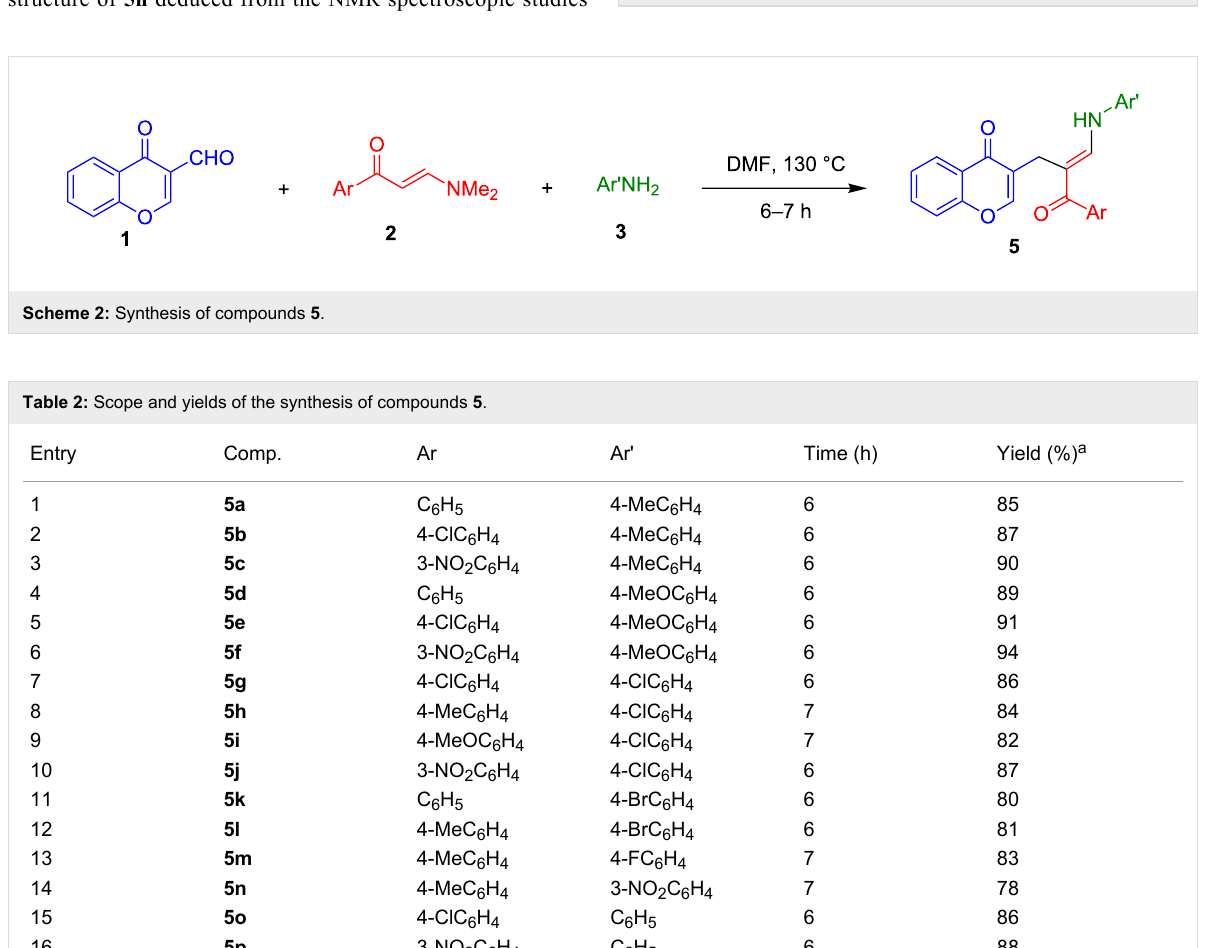
Figure 1: X-ray structure of compound 5h